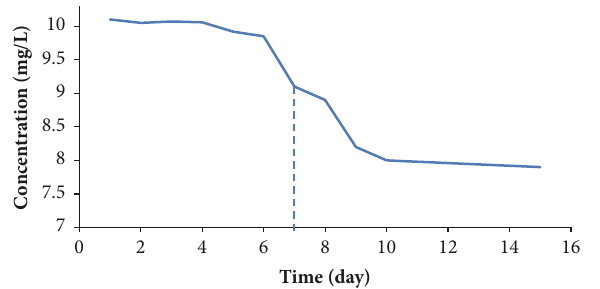
Figure 2: Stability of formaldehyde derivatized product over 2 weeks for 10.0 mg L formaldehyde standard.